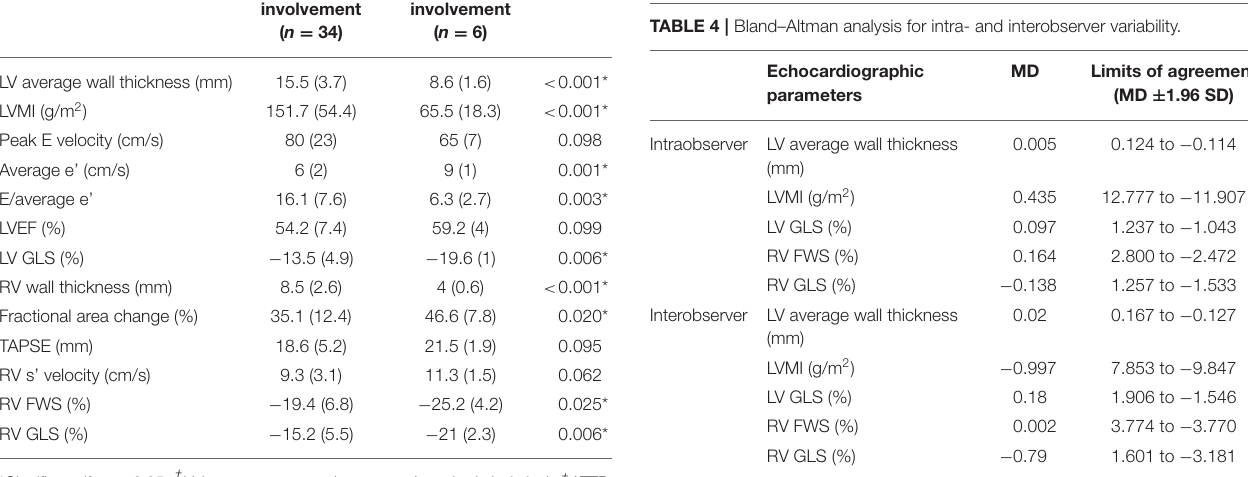
Frontiers in Cardiovascular Medicine |